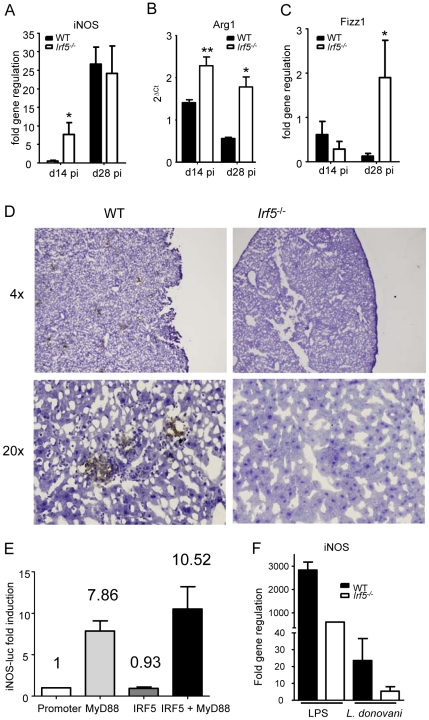
IRF-5 deficiency results in defective iNOS production.Real time PCR analysis of livers from infected mice measuring mRNA for iNOS (A), arginase1 (B) and Fizz1 (C). All data is presented as the mean ± SEM combined from two independent experiments, n = 6-9 mice per group. (D) iNOS protein in the liver was examined by immunohistochemistry. (E) Induction of the NOS2 promoter by MyD88 and IRF-5 was measured by luciferase assay. Data shown is fold induction of the promoter compared to promoter only controls and represents the mean± SEM for triplicate samples from 2 independent experiments. * denotes p<0.05 and ** denotes p<0.01. (F) Real time PCR analysis of iNOS mRNA in WT and Irf5-/- macrophages stimulated with LPS and/or L.donovani amastigotes. Data is shown for n = 3.